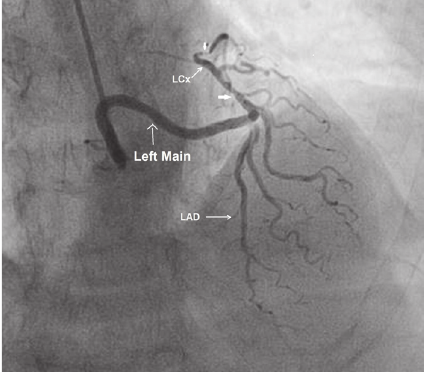
Figure 3: LMCA arising from right sinus revealing type II LAD and critical stenosis in LCx in AP caudal view.